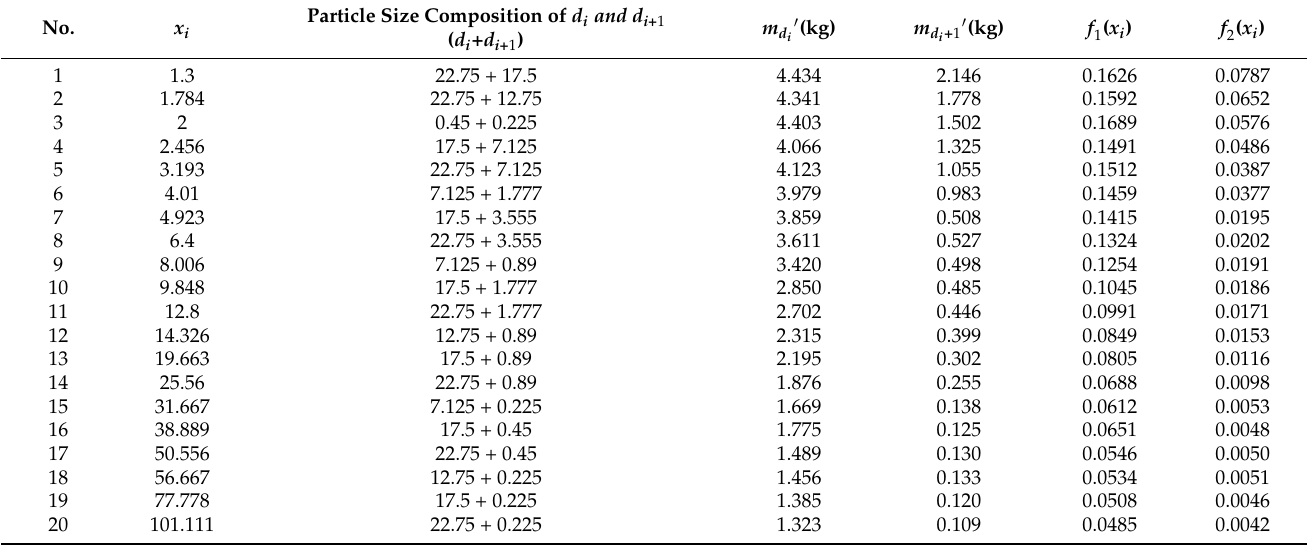
Table 1. The particle binary packing test.